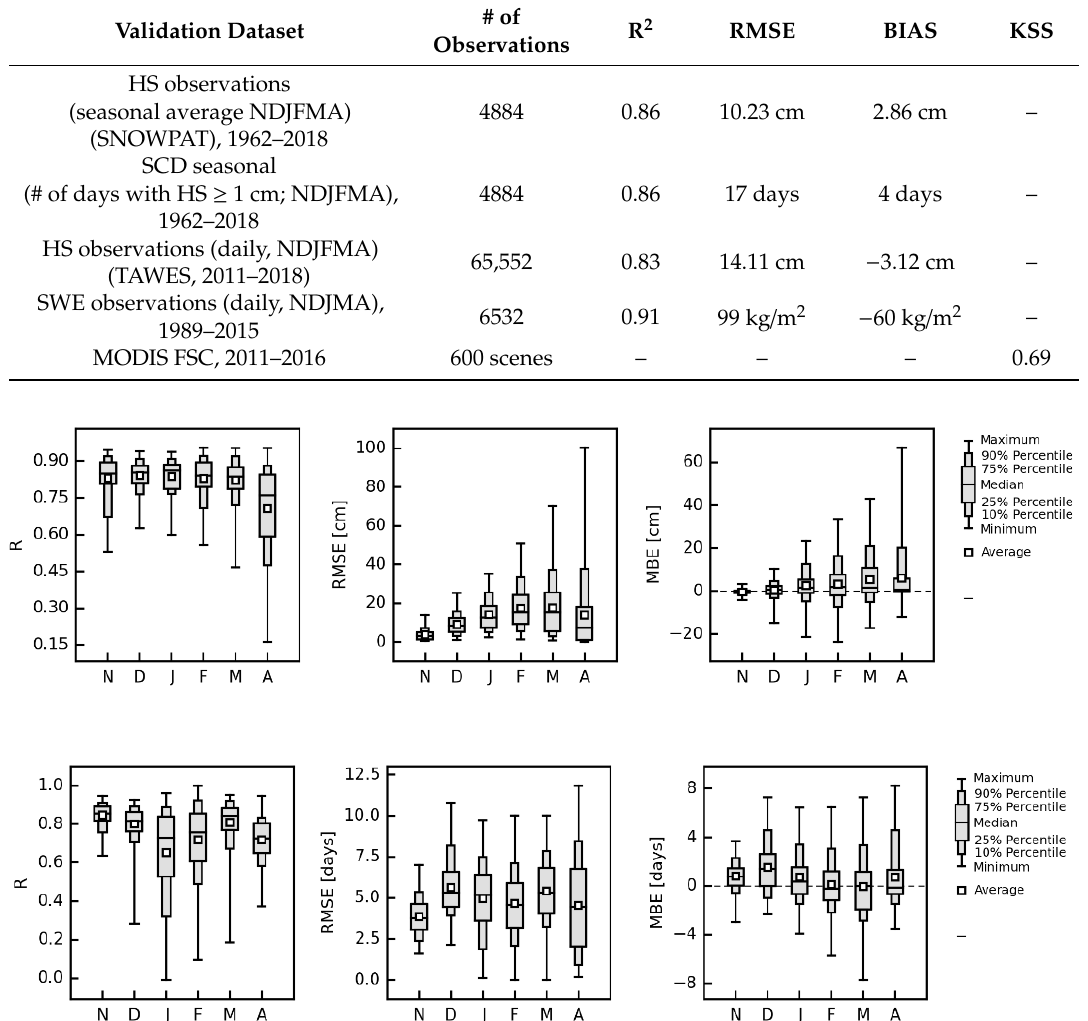
Figure 3. Box plots of performance measures (R, RMSE, and BIAS) for monthly mean snow depth HS ( top row ) and snow cover duration SCD (HS ≥ 1 cm) ( bottom row ). The evaluation period covers the winter seasons from 1961/62 to 2017/18.